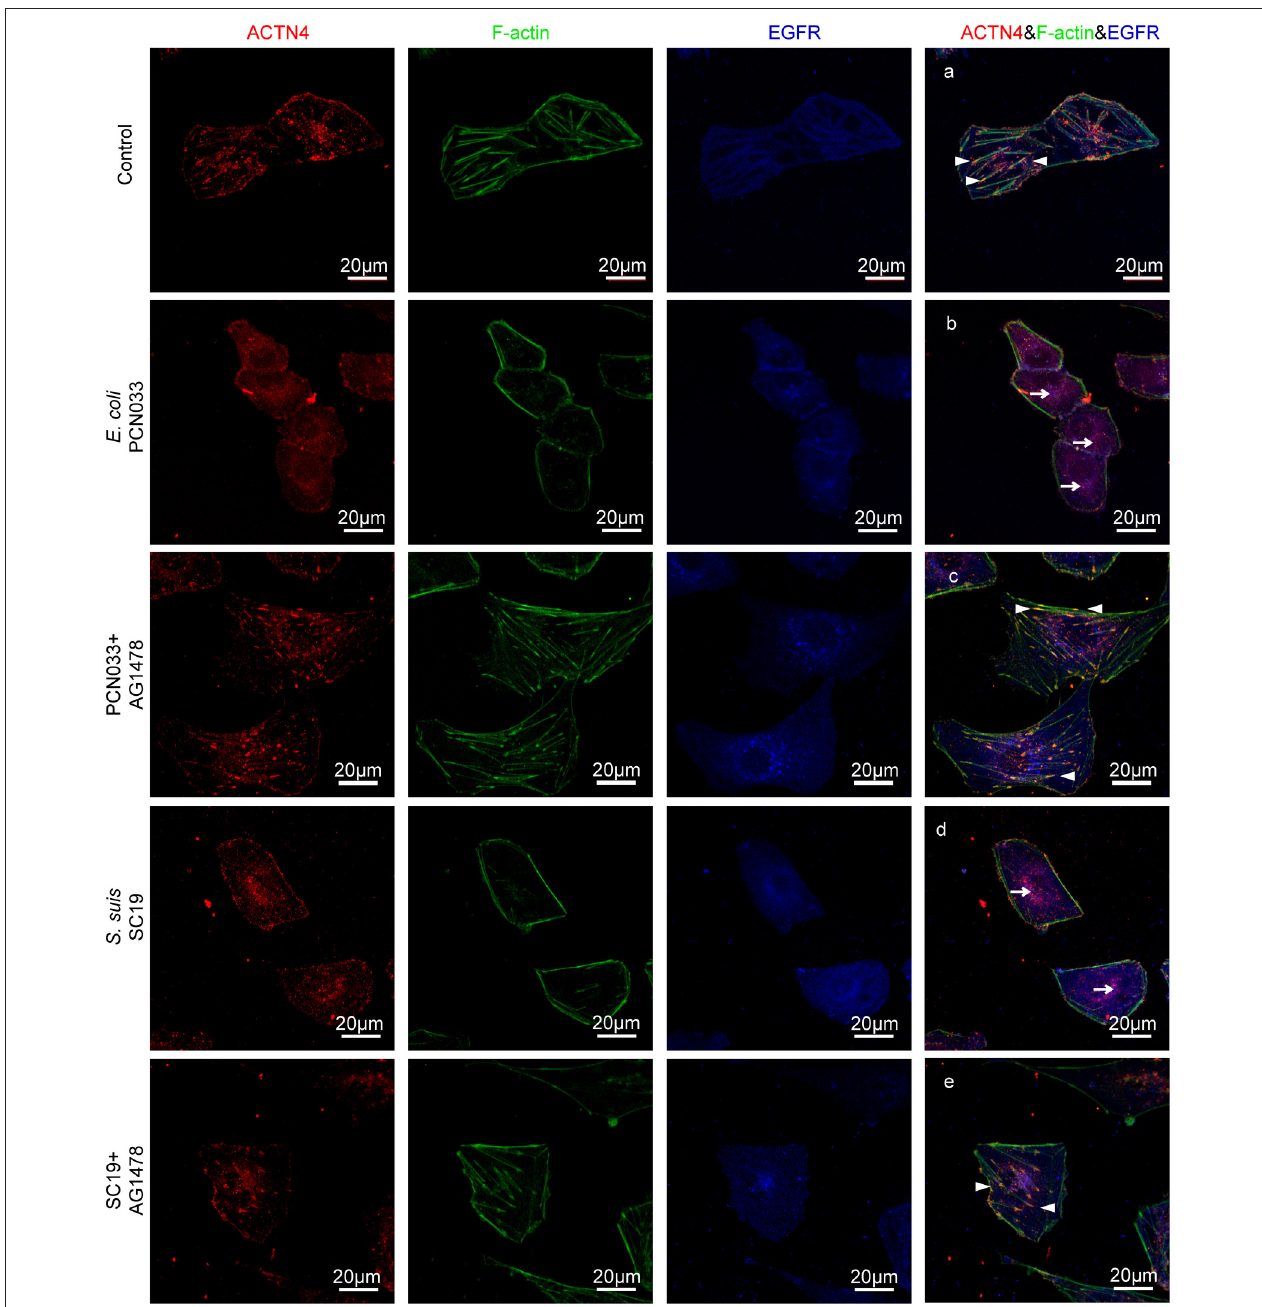
FIGURE 7 | Confocal fluorescence microscopy showing activated EGFR competitively recruiting ACTN4 from intracellular F-actin in response to meningitis-causing bacteria. The meningitic E. coli and S. suis infections were conducted with or without AG1478 pretreatment of the cells as follows. (A) Normal hBMECs without challenge, (B) The cells infected with PCN033, (C) The cells treated with AG1478 prior to PCN033 infection, (D) The cells infected with SC19, (E) The cells treated with AG1478 prior to SC19 infection. ACTN4 was labeled with Dylight 405, EGFR was labeled with Cy3, and F-actin was stained with actin-tracker green. The arrow heads indicate the co-location of ACTN4 and F-actin, and the arrows indicate the co-location of ACTN4 and EGFR. The cells were mounted and then visualized using the Zeiss LSM 880 confocal system.